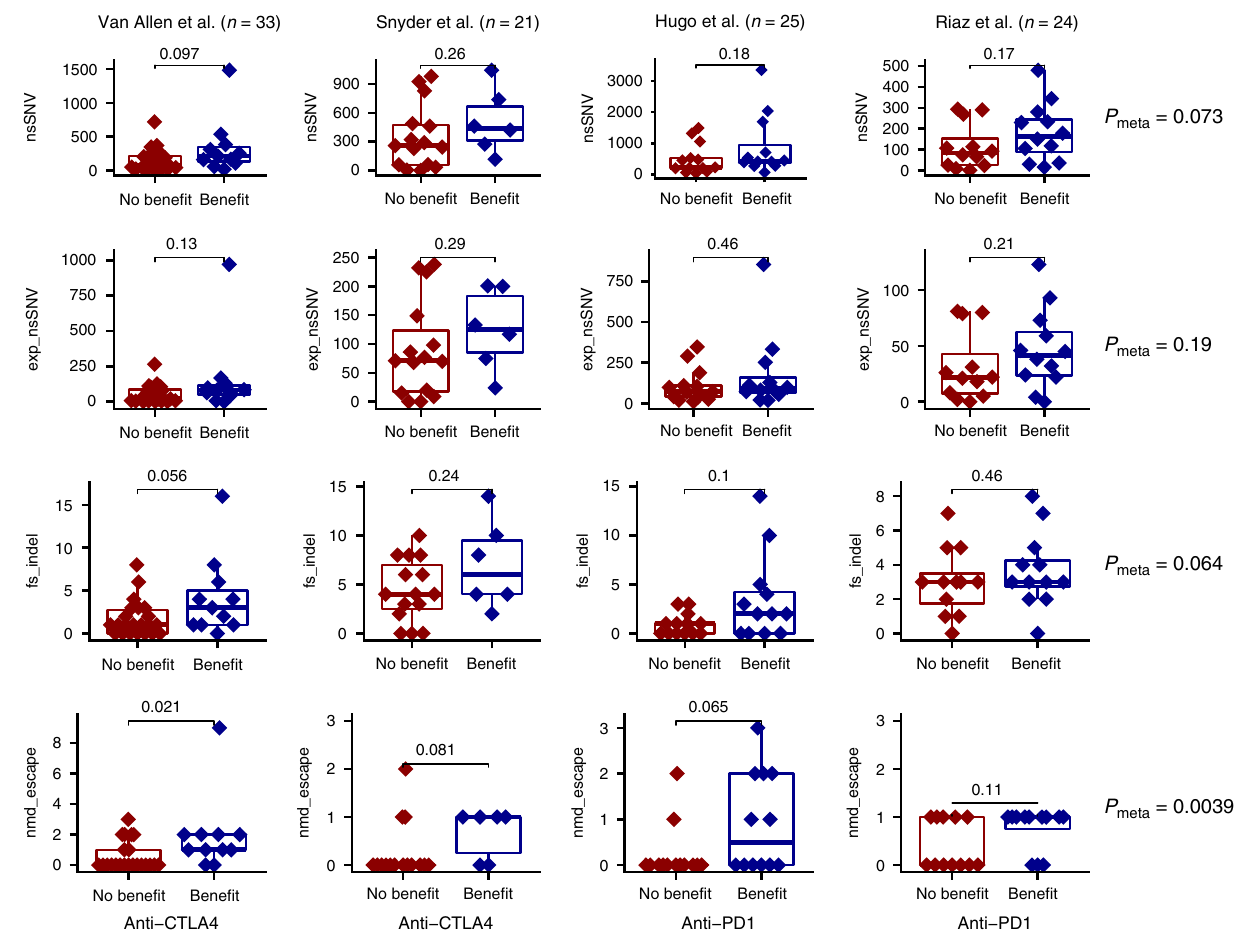
Fig. 3 NMD-escape mutation count predicts immune checkpoint inhibitor response. Shows four melanoma checkpoint inhibitor (CPI) treated cohorts, split into groups based on no-clinical bene fi t (dark red) or clinical bene fi t (dark blue) to therapy. Four metrics are displayed per cohort: (top row) TMB non- synonymous SNV count, (second row) expressed non-synonymous SNV count, (third row) frameshift indel count and (fourth row) NMD-escape mutation count. In the fi rst column is the Van Allen et al. 8 anti-CTLA-4 cohort ( n = 33 patients), second column is the Snyder et al. 7 anti-CTLA4 cohort ( n = 21 patients), the third column is the Hugo et al. 4 anti-PD1 cohort ( n = 25 patients) and the fourth column is Riaz et al. 20 anti-PD1 cohort ( n = 24 patients). Far right are meta-analysis p -values, for each metric across the four cohorts, showing the association with clinical bene fi t from CPI treatment. Two-sided Mann – Whitney U test was used to assess for a difference between groups. Meta-analysis of results across cohorts was conducted using the Fisher method of combining P values from independent tests. In all boxplots in this fi gure the centre line is the median, the bounds of the box represent the inter-quartile range, the lower whisker = max(min(x), Q_1 − 1.5 × IQR) and upper whisker = min(max(x), Q_3 + 1.5 ×